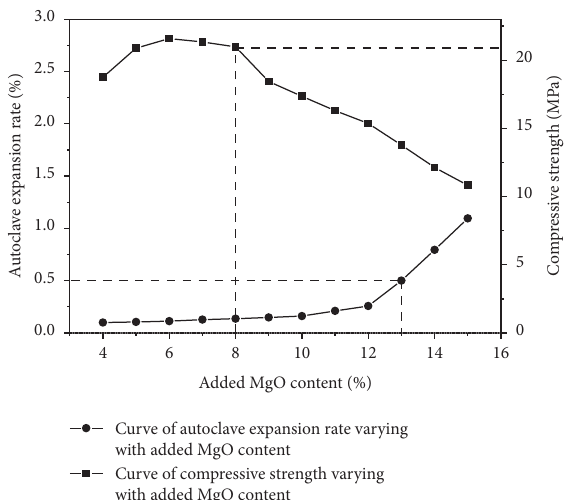
Curve of autoclave expansion rate varying with added MgO content Curve of compressive strength varying with added MgO Figure 5: Effect of MgO content in mortar specimens on autoclave expansion rate and compressive